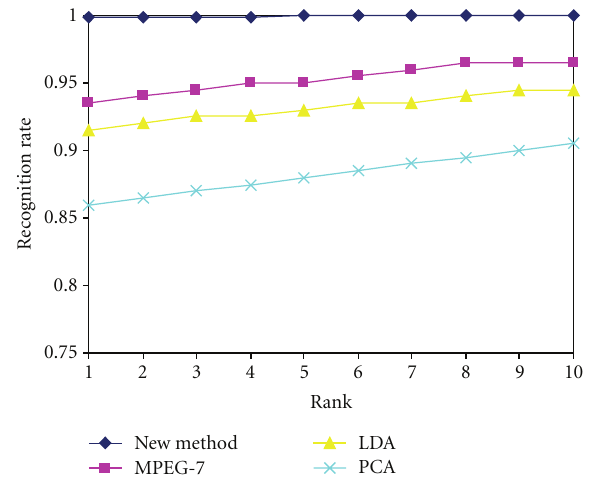
Figure 6: CMS results for the ORL database.